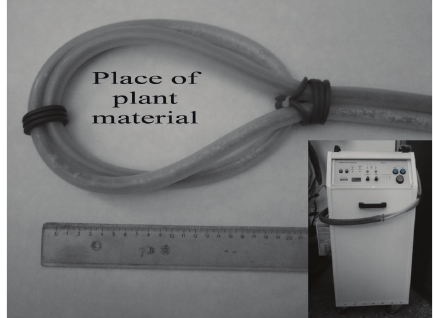
Figure 4: PAPIMI device and external